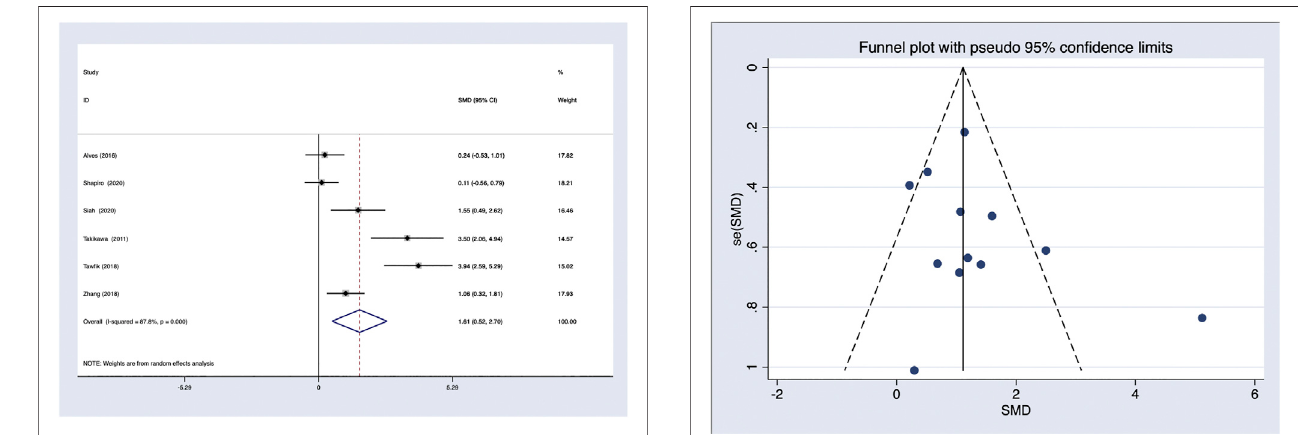
FIGURE 9 | Funnel plot of studies compared the ef fi cacy complared to the